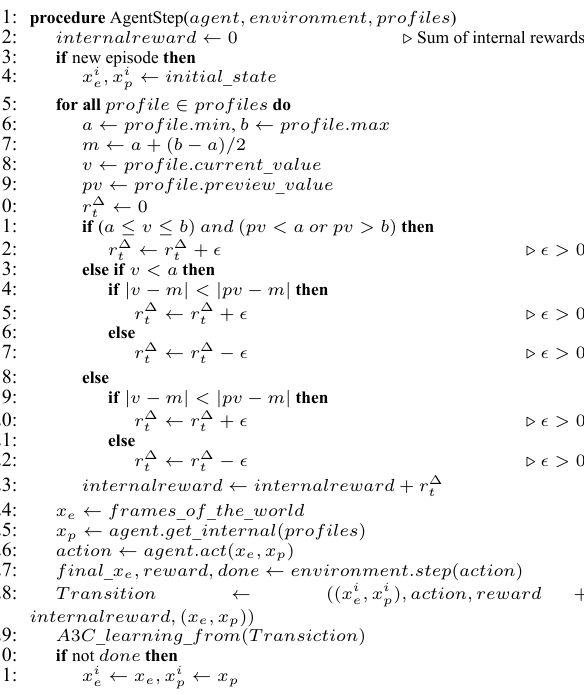
Algorithm 2 Agent Without Explicit Goals (A3CWEG). Agent, environment, and profiles are objects that encapsulate agent, environment, and agent’s profile.